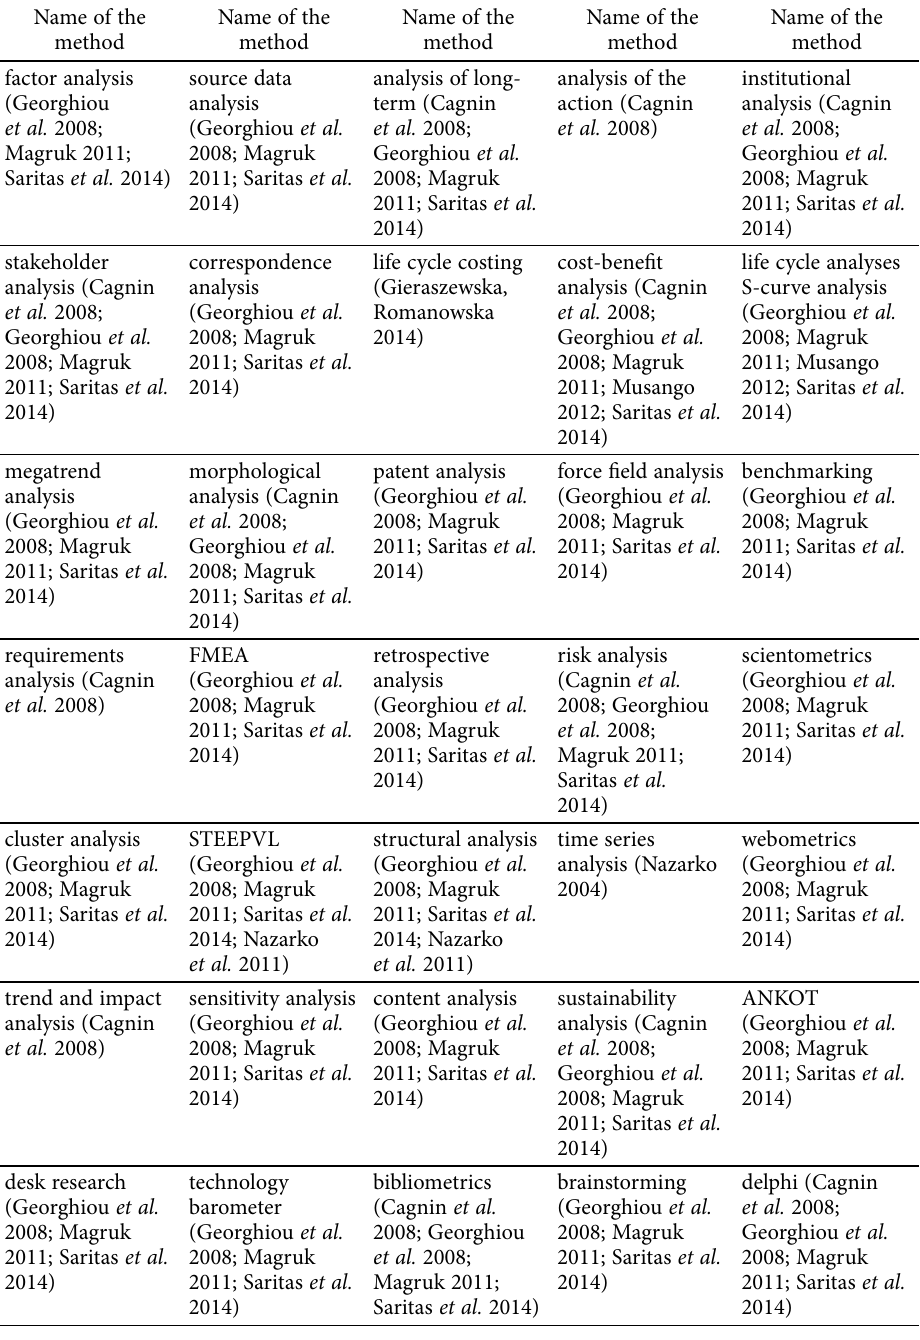
Table 2. Methods with potential use in the FTA technological